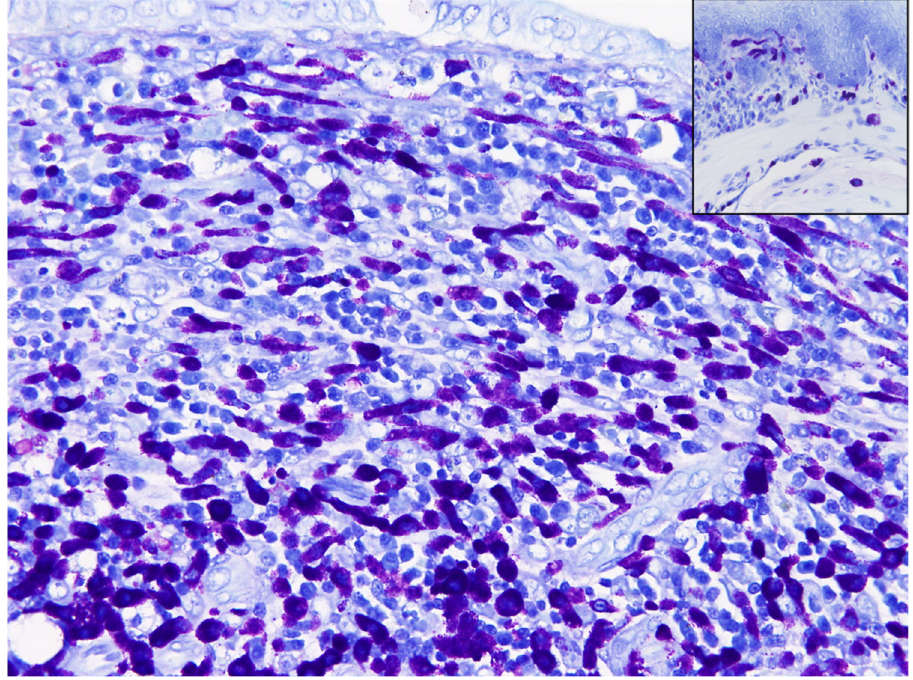
Figure 7. Gastric mast cell tumor (MCT), African dormouse, stomach, Toluidine blue stain. The neoplastic cells show strong metachromasia (400×). Both of MMCs and connective tissue mast cells (CTMCs) in the esophagus also show metachromasia (inset) (400×).